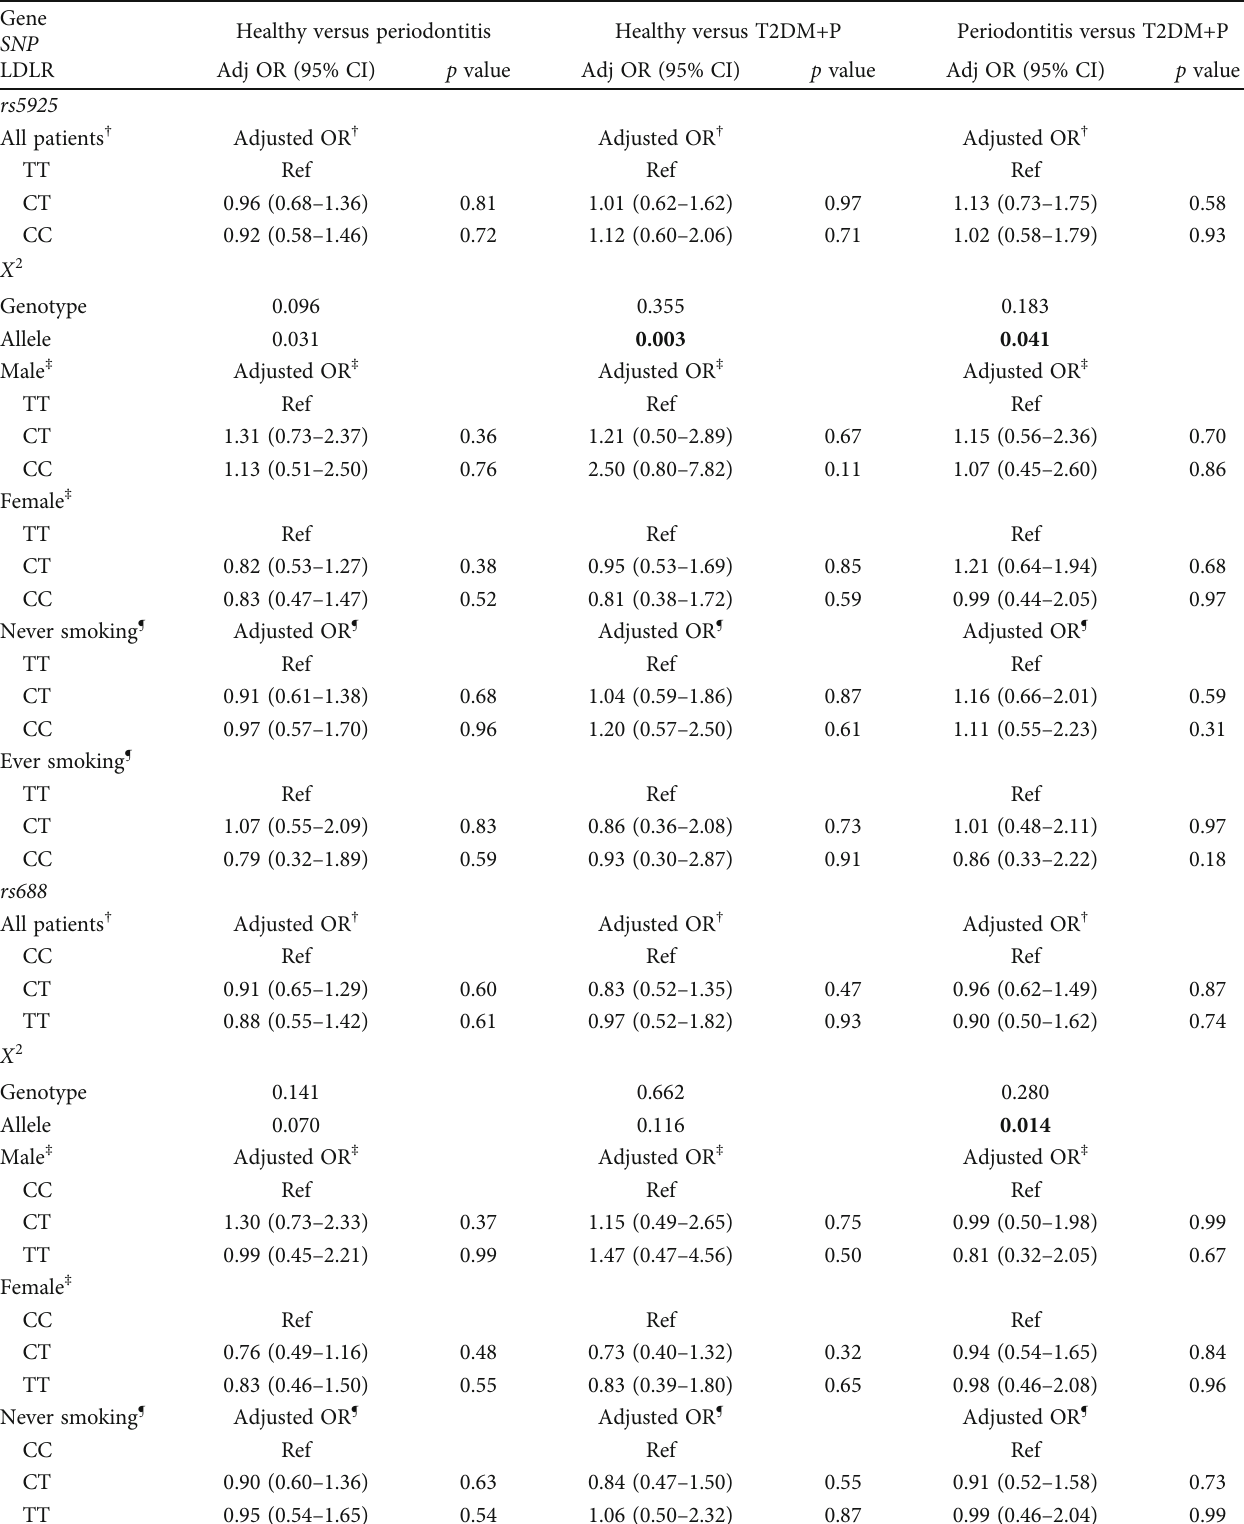
Table 3: Multiple logistic regression analyses for all patients (adjusted by age, sex, and smoking), for patients strati fi ed by sex ‡ (adjusted by age and smoking) and by smoking habits (adjusted by age and sex). Chi-squared test ( X 2 ) for genotypic and allelic